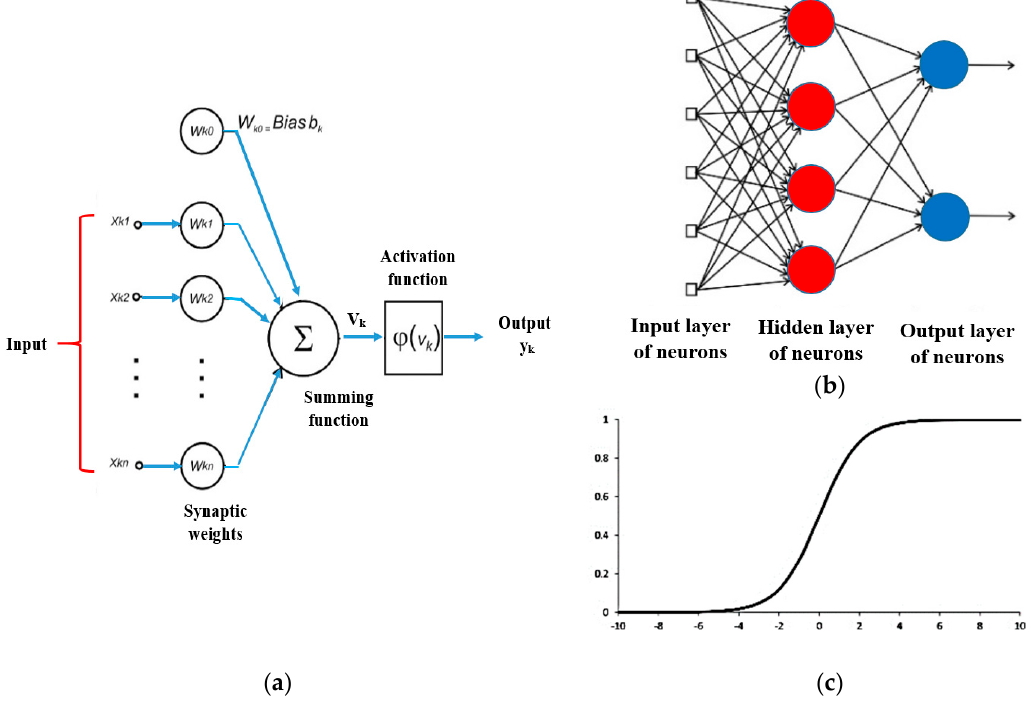
Figure 12. Schematic representation of an artificial neural network (ANN) architecture and basic operations ( a ), schematics of a three-layer neural network model layer ( b ), example of activation function ( c ) (own study based on [45]).